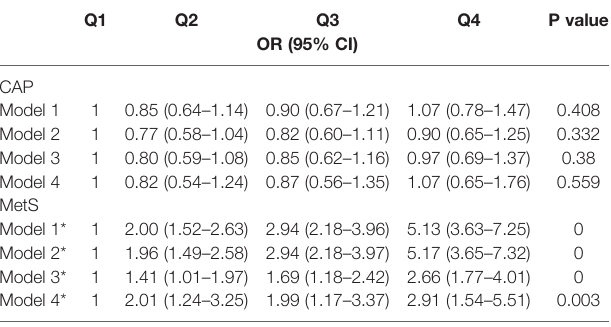
Model 1 adjusted for age and gender. Model2furtheradjustedforalcoholdrinking, smoking,durationofdiabetes,hypertension, and history of CVD. Model 3 further adjusted for BMI.